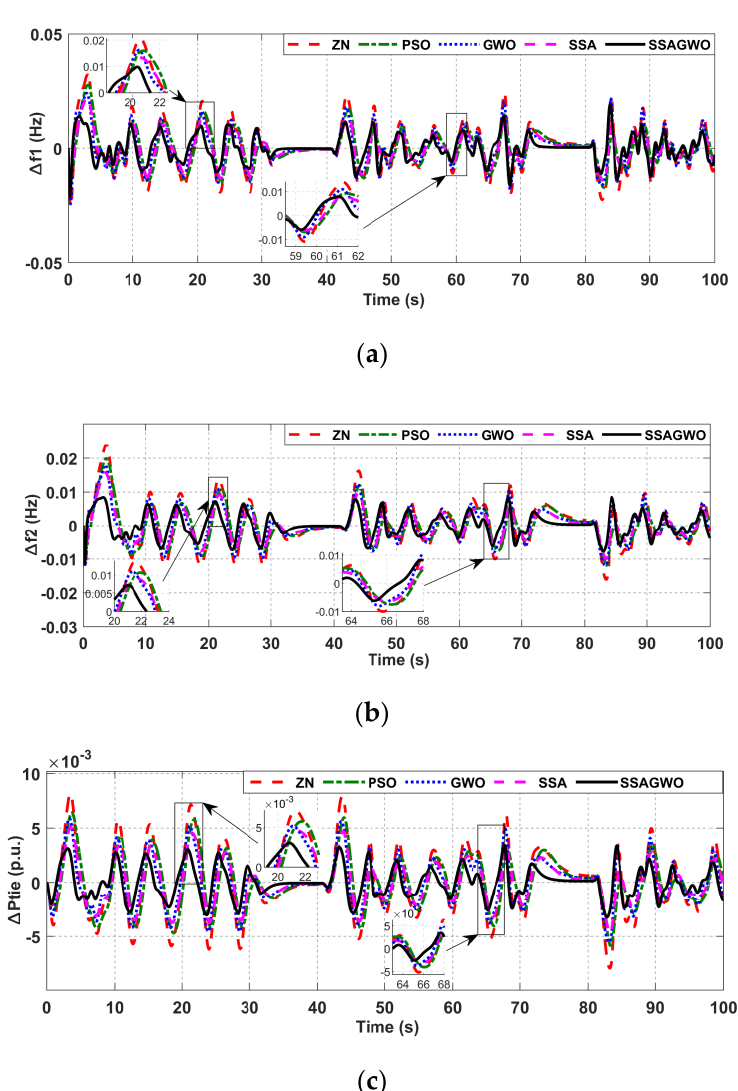
Figure 14. Realize solar input power.